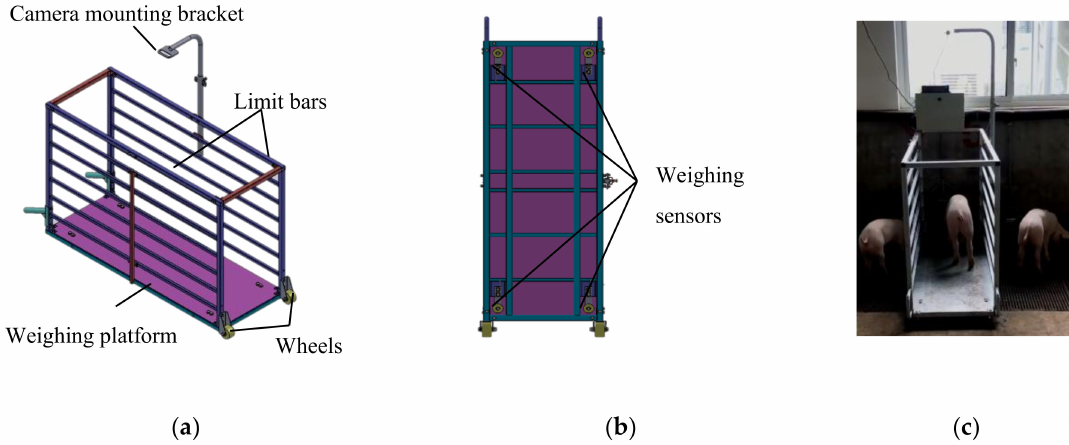
Figure 1. Pig weight and back image acquisition system: ( a ) three-dimensional diagram of system; ( b ) distribution of weighing sensors; ( c ) photo of system.